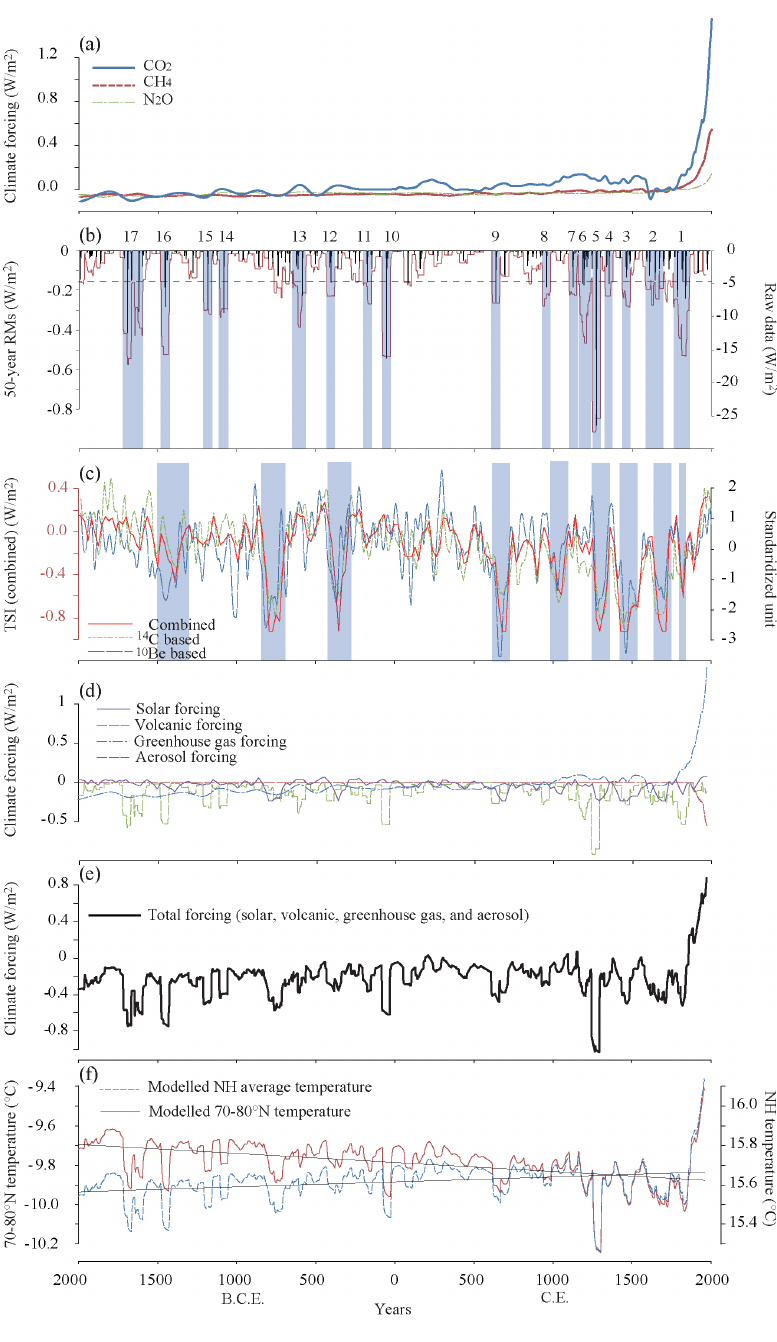
Fig. 5. Climate forcings and 1-D EBM output over the past 4000yr. (a) Greenhouse gas forcings by CO 2 , CH 4 , and N 2 O from 2000BCE to 2000CE. The values at 1750CE were defined as zeros. See text for the data sources. (b) Volcanic forcing for NH over the past 4000yr derived from the GISP2 sulfate record (Mayewski et al., 1997). Black and red lines are raw data and 51yr RMs for reconstructed volcanic signals, respectively. Blue shaded areas are periods when volcanic forcings were lower than the standard deviation ( − 0.15Wm − 2 ; dotted line) of the 51yr RMs and lasted for more than 50yr. Seventeen volcanically active periods were identified (Table 1). (c) TSI anomaly over the past 4000yr from the value of 1365.57Wm − 2 in 1986. Data are plotted on the standardized unit (mean zero and standard deviation of one) to show differences in trend but not in absolute values. The data for combined, 14 C-based, and 10 Be-based estimates are from Steinhilber et al. (2012), Vieira et al. (2011), and Steinhilber et al. (2009), respectively. Left y axis is for the combined TSI (Steinhilber et al., 2012), which was used in the 1-D EBM. Shaded areas indicate periods of weaker solar activity. (d) Climate forcings from 2000BCE to 1976CE. (e) Total climate forcings. This is sum of various forcings (d) . (f) Modelled NH and 70–80 ◦ N temperatures using the 1-D EBM with the total climate forcing as in (e) and the orbital forcing in the Fig. 4 (see